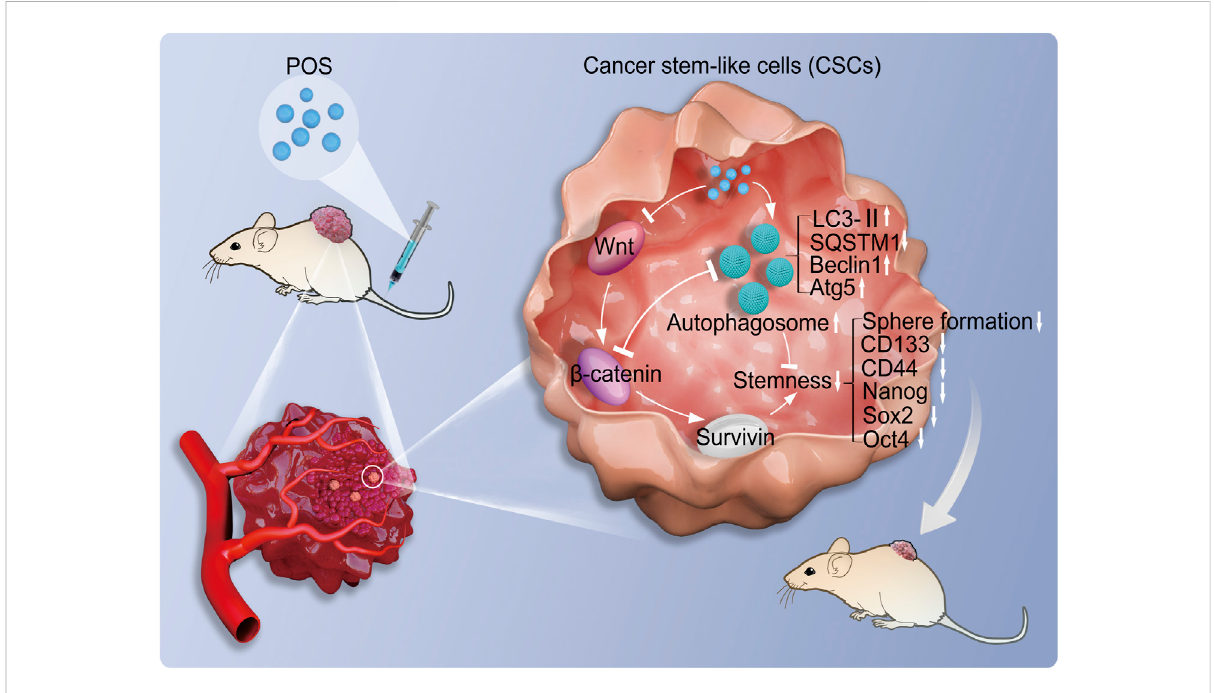
FIGURE 9 MolecularmechanismsofPOSweakensCSCsstemnessinGBM.POSinhibitsCSCsstemnessbyautophagyinductionandsuppressingtheWnt/ β -catenin/survivin signaling